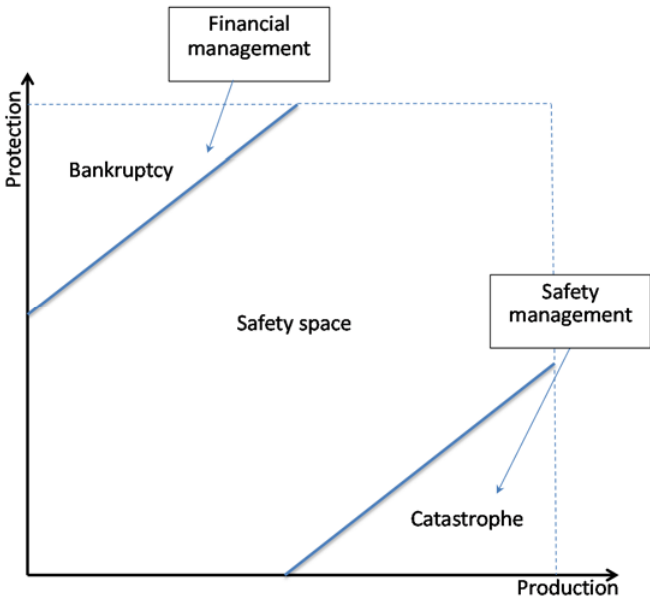
Figure 7. Safety space (from [30]).